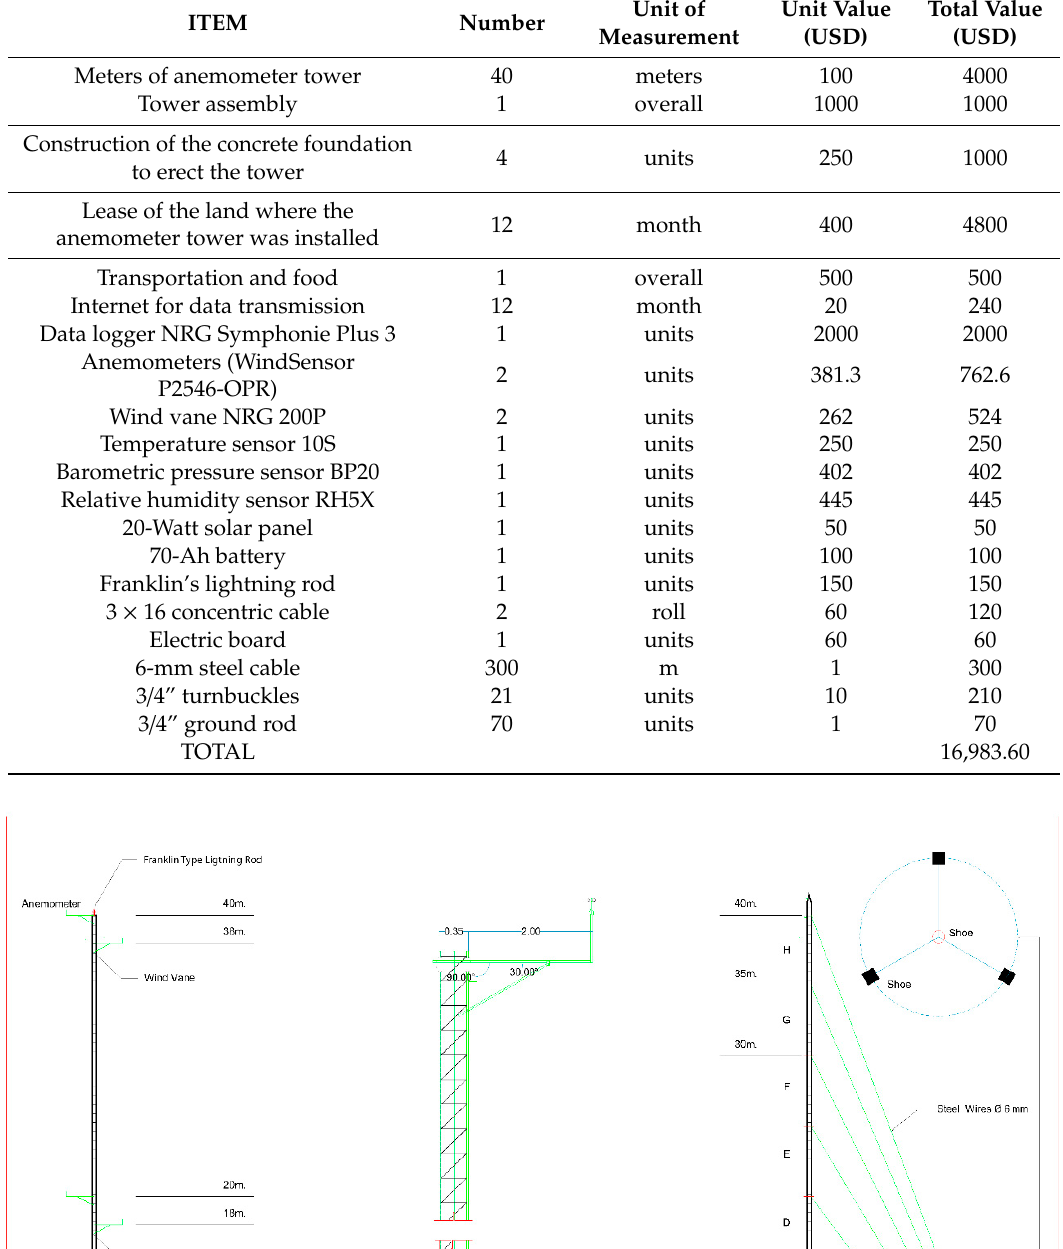
Table 2. Costs of equipment and materials used.